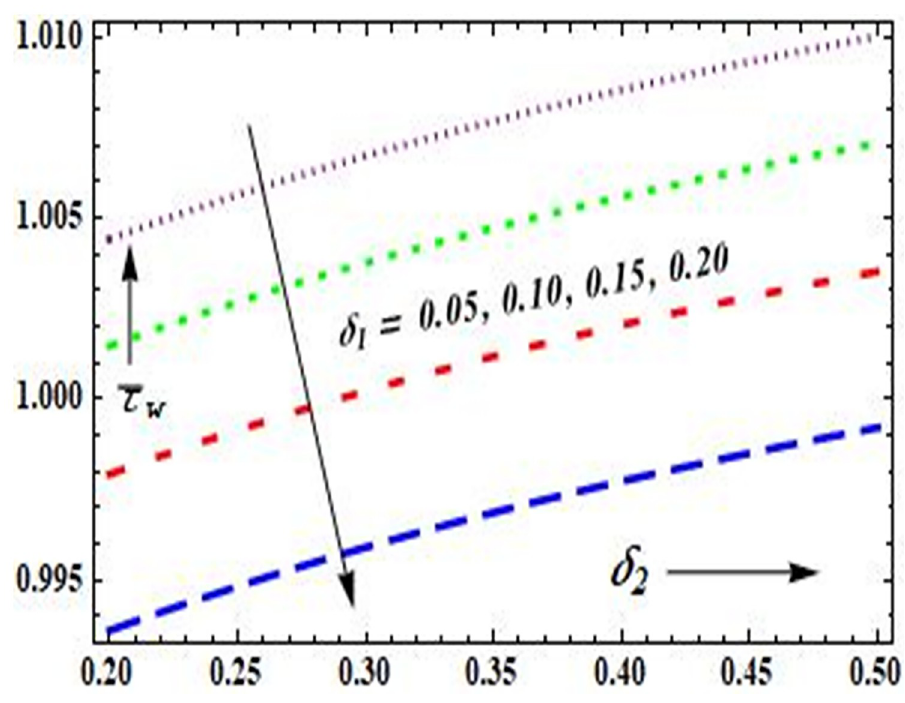
Fig 17. Plot of � τ